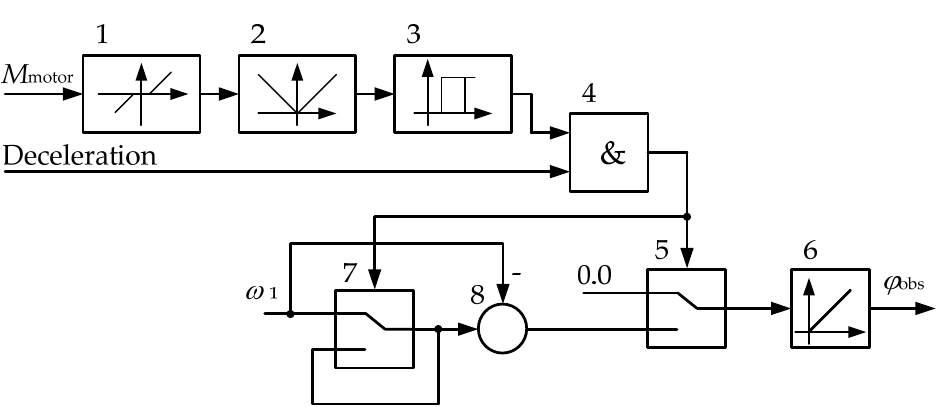
Figure 6. Block diagram of the mechanical transmission angular gap observer: 1—dead zone block; 2—signal module calculation block; 3—relay block; 4—conjunction element; 5, 7—switch blocks (controlled switches); 6—integration block; 8—adder.